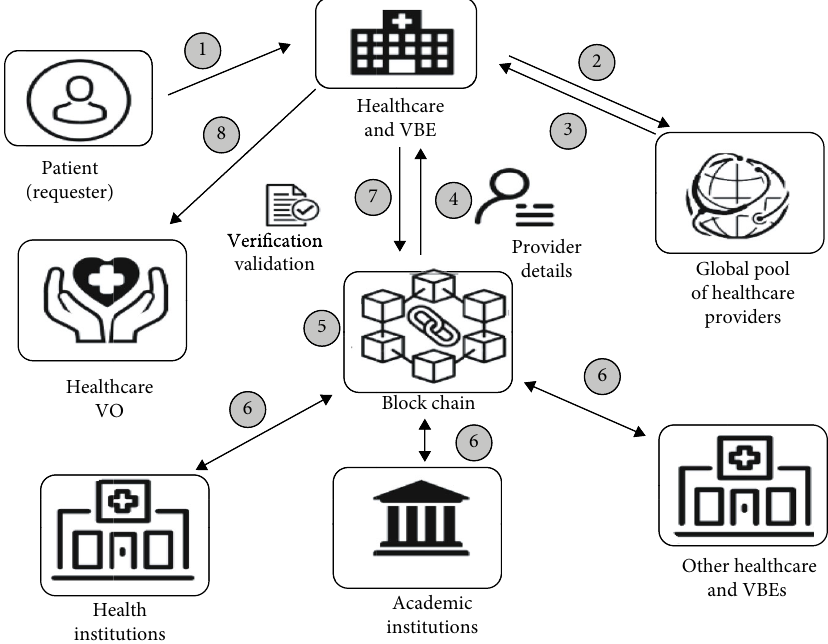
Figure 9: Service provider validation and veri fi cation framework for the blockchain-based healthcare system.